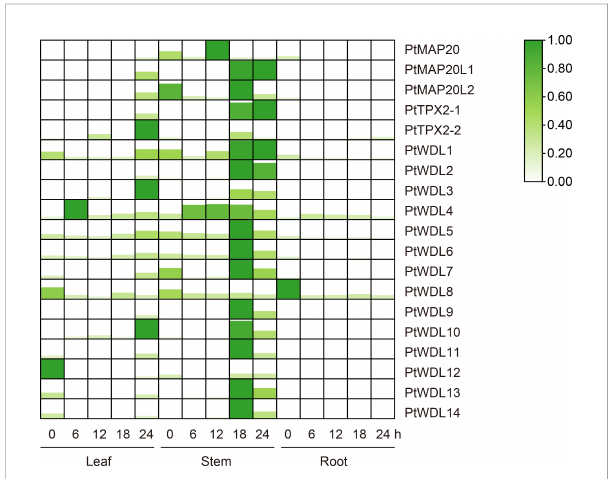
FIGURE 10 Heatmap of PtTPX2 gene expression patterns in different tissues and processing time under drought stress. The graphic size and color represent the level of expression of each gene in each sample. The gene expression levels were calculated based on 2 − DD Ct